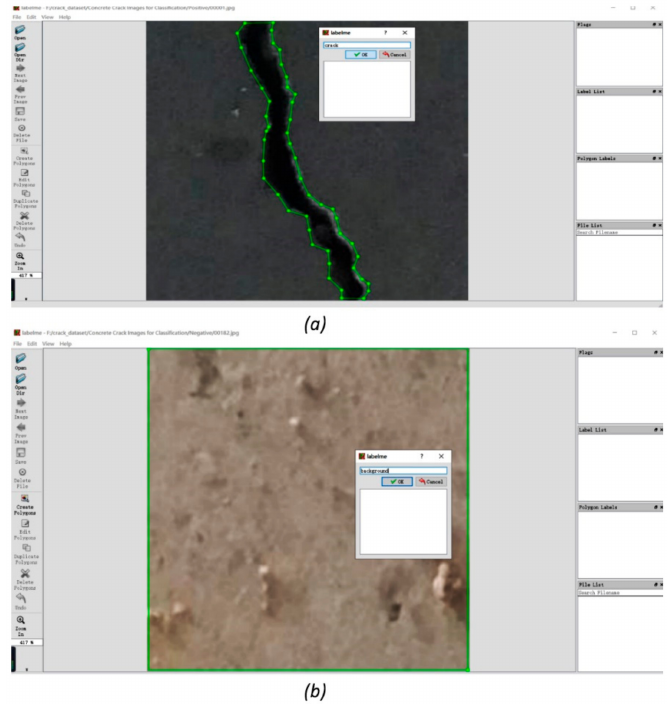
Figure 3. Crack ( a ) and background ( b ) annotation interfaces.